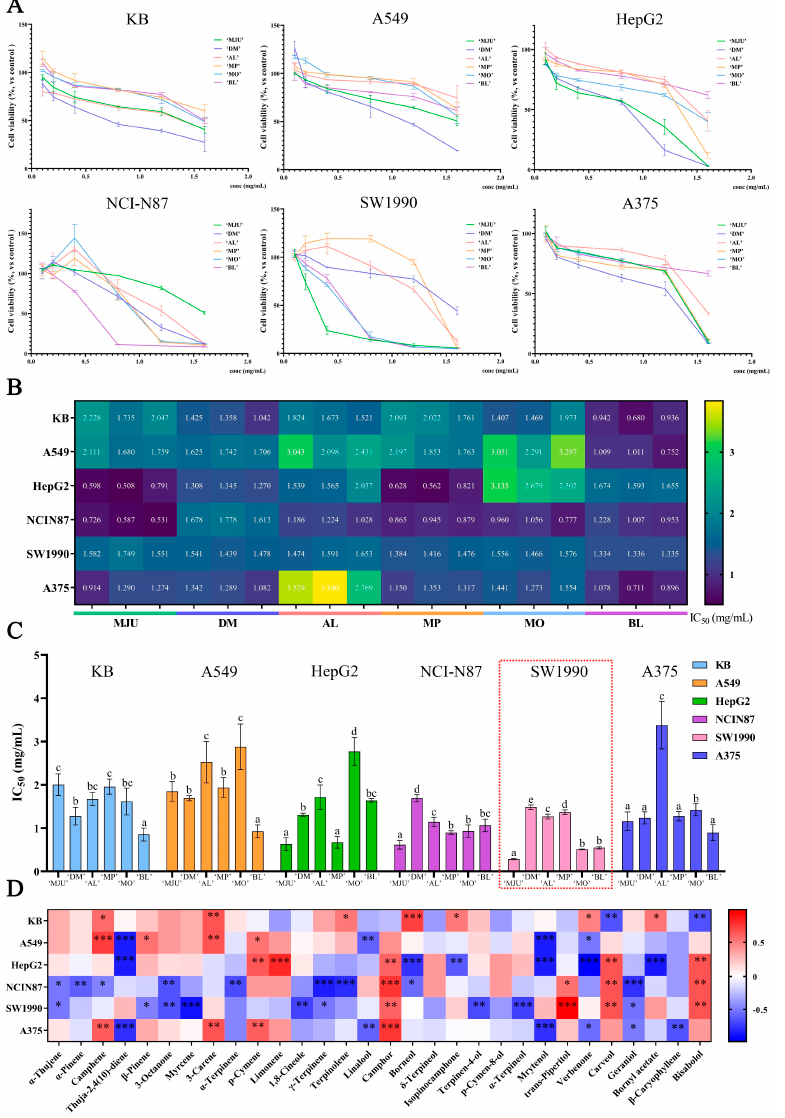
Figure 4. ( A ) The cytotoxicity of REOs on 6 cancer cells. ( B ) The heatmap of IC 50 of REOs on 6 cancer cells. ( C ) The IC 50 of REOs on 6 cancer cells. ( D ) The heatmap of Spearman correlation coefficient results between component and cytotoxicity. Data were expressed as means ± standard deviation (SD) (* 0.01 < p < 0.05, ** 0.001 < p < 0.01, *** p < 0.001). Means with different letters in the same cell line are significantly different ( p < 0.05).